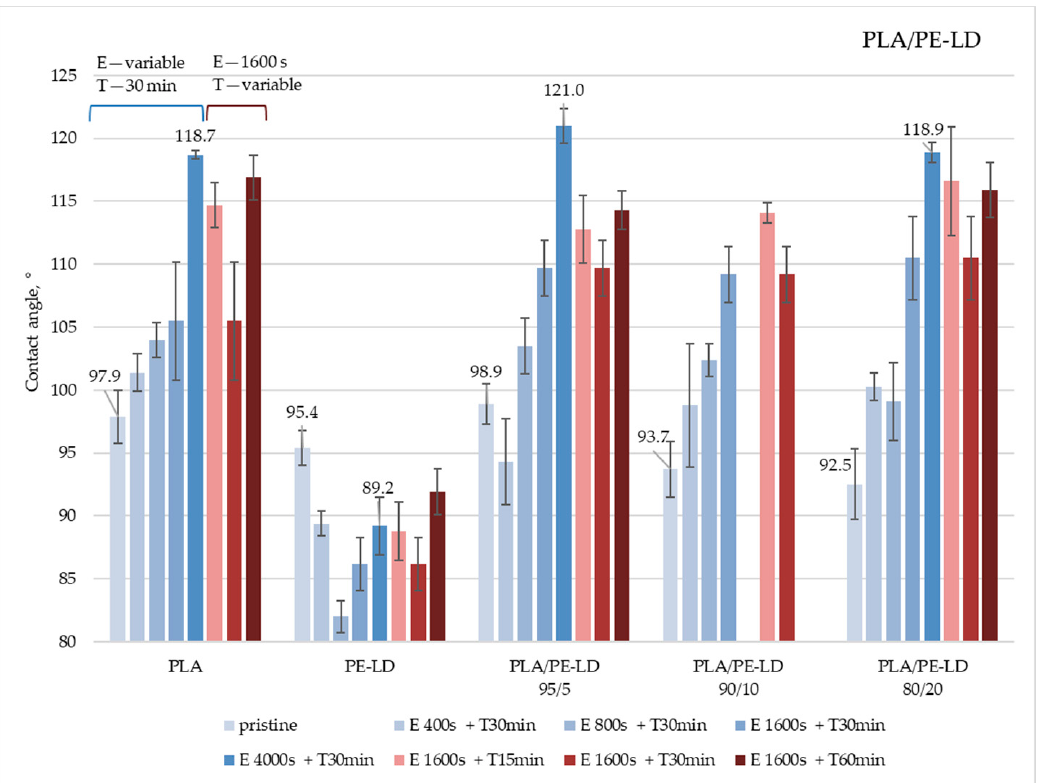
Figure 3. Water contact angles on Polylactide (PLA) / low-density polyethylene (PE-LD) polymer blends treated under different etching and coating conditions (E—etching; T—CF x coating).